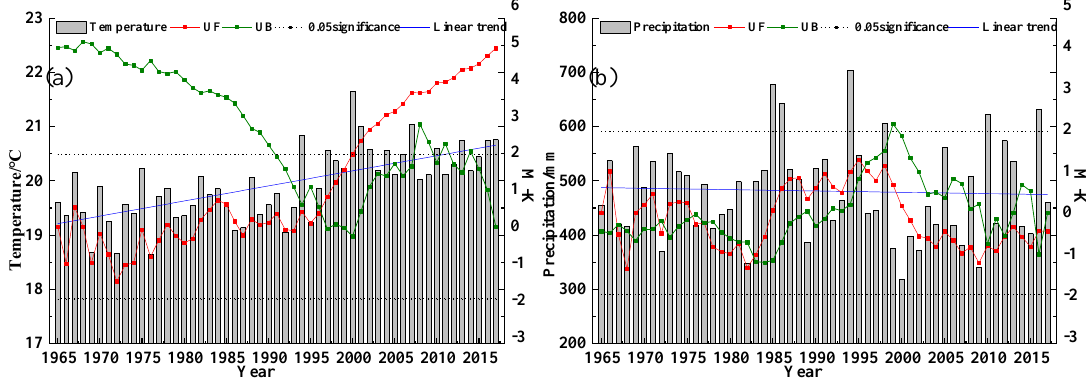
Figure 2. Variation and linear trend of temperature ( a ) and precipitation ( b ) in growing season and Mann–Kendall (M–K) mutation test.